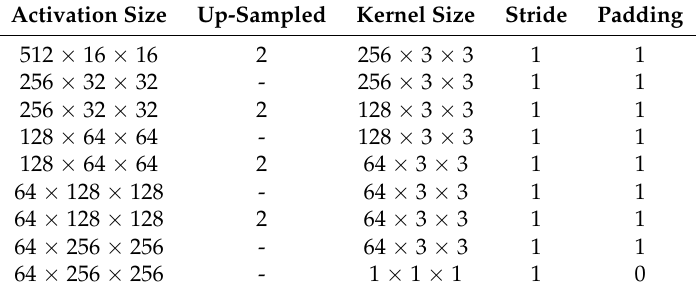
Table 2. The detailed information of decoder. The data output from the encoder is first up-sampled and then spliced by channel for twice (Conv + Relu) operations, after four times, the final (Conv + Relu) is